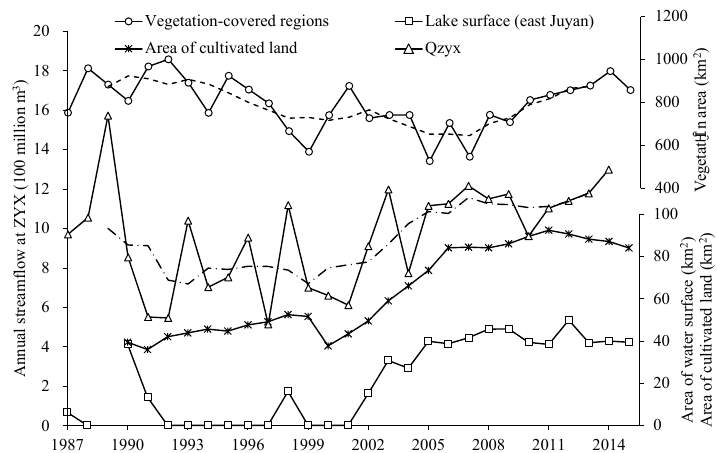
Figure 4. Temporal variations in river discharge at ZYX (triangle), annual total vegetation-covered regions (circle), East Juyan Lake surface area (square) and cultivated lands (cross) from 1987 to 2015. The dash line and dash-dot line denote the 5-year moving average values for vegetation areas and streamflow at ZYX